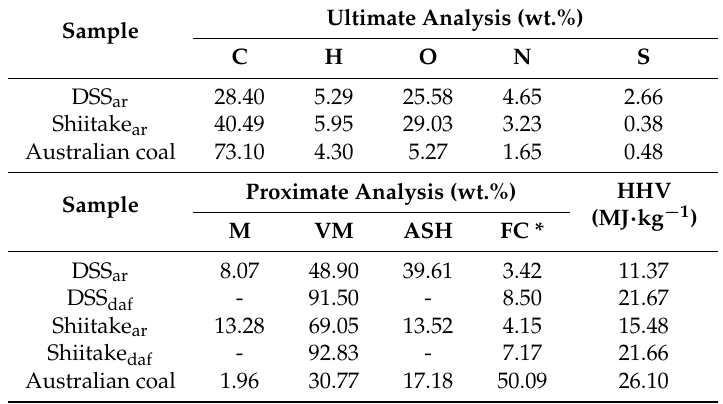
Table 2. Ultimate analysis and proximate analysis of sewage sludge, shiitake, and Australian coal. Ultimate Analysis (wt.%) Sample C H